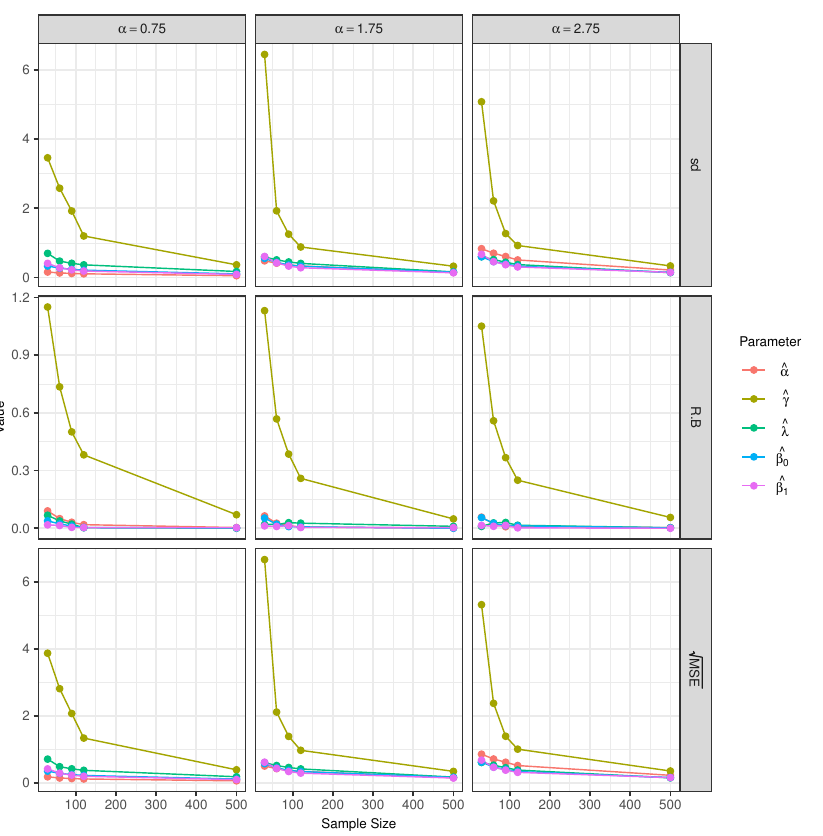
√ MSE for the estimators of the EGSHN ( α ,2.25,0.75,1.5,1 )